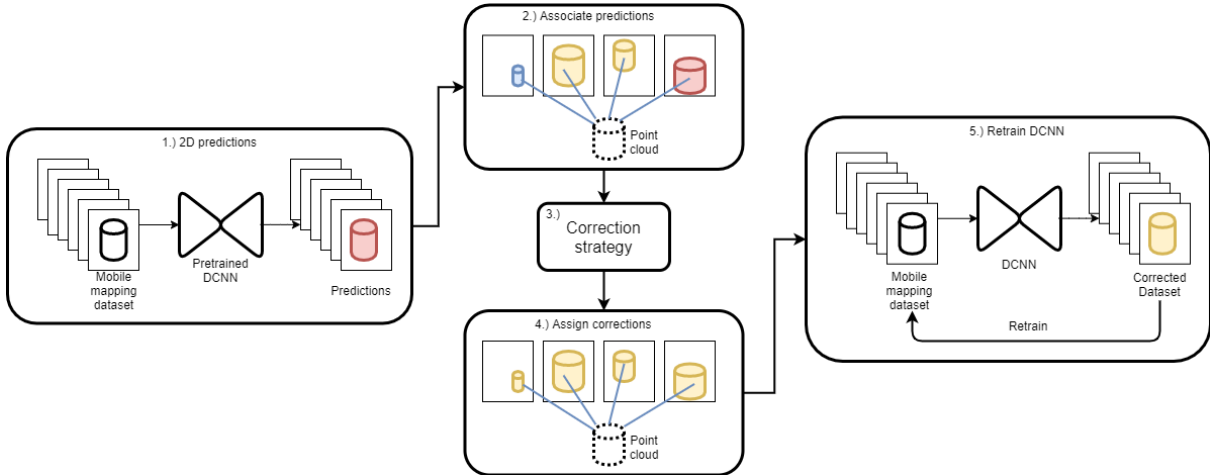
Figure 3. Methodology for retraining the DCNN on a new dataset. Colors are indicating different class predictions. The cylinder shows the same object observed in multiple